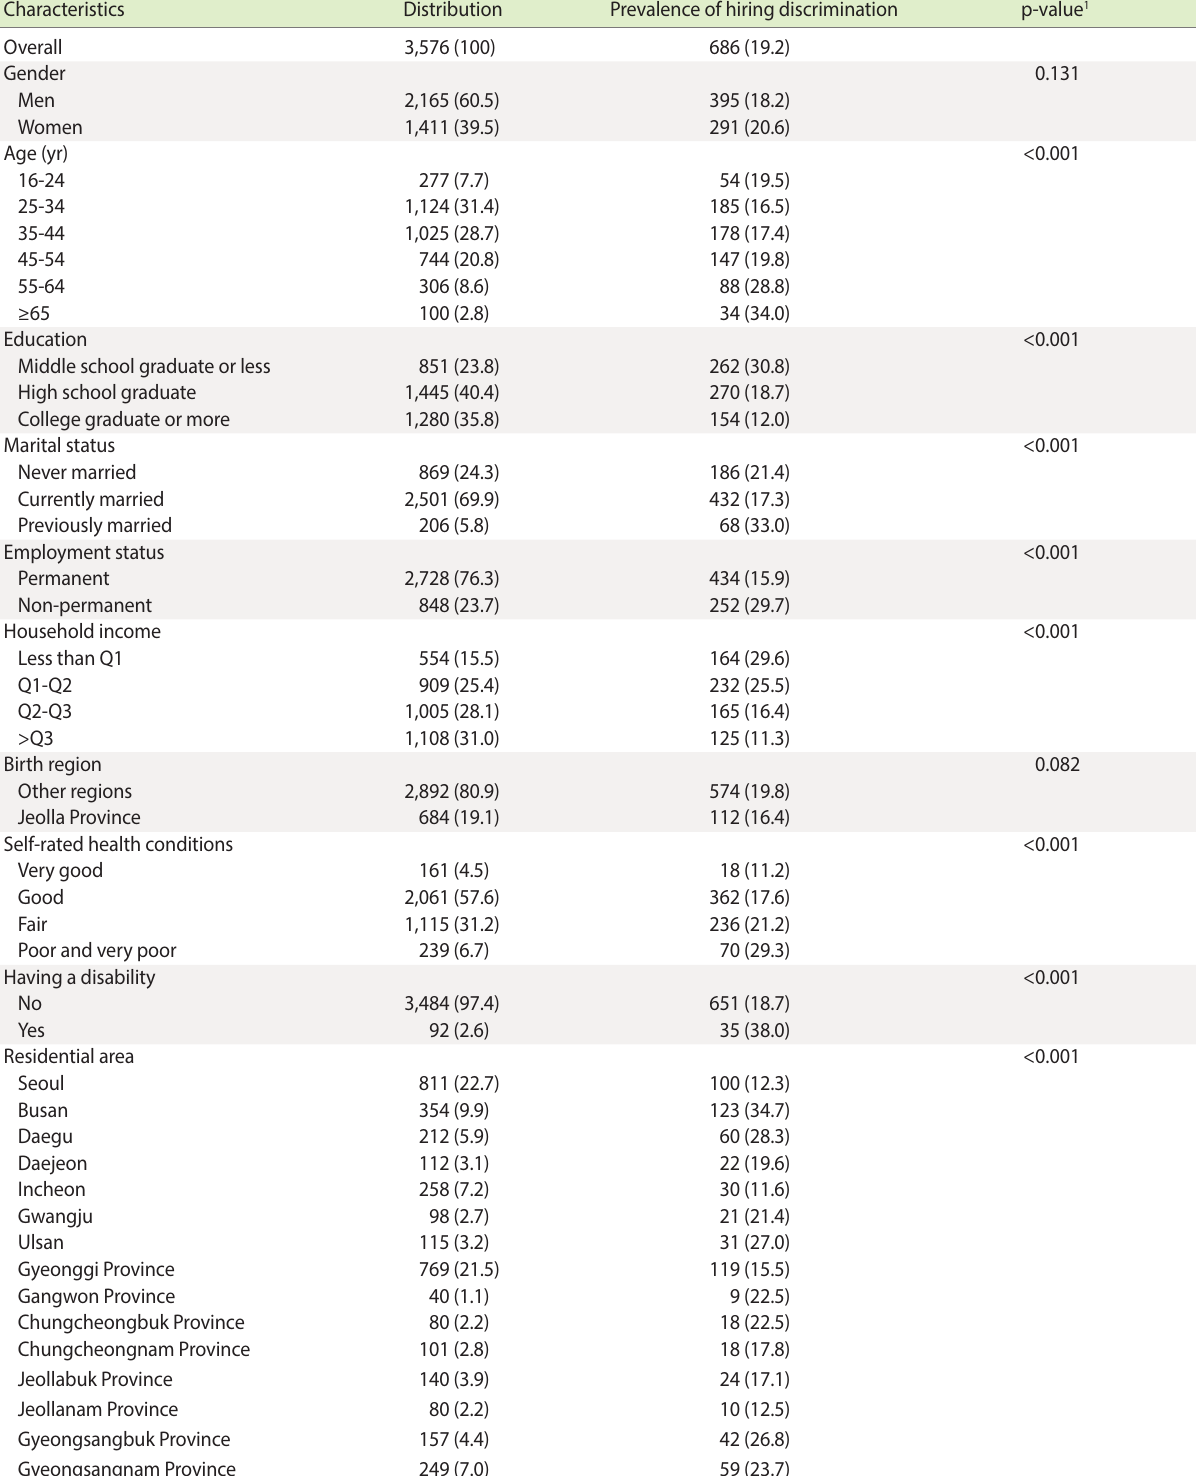
Table 1. Distribution of the study population and prevalence of hiring discrimination by predictors among wage workers in Korea